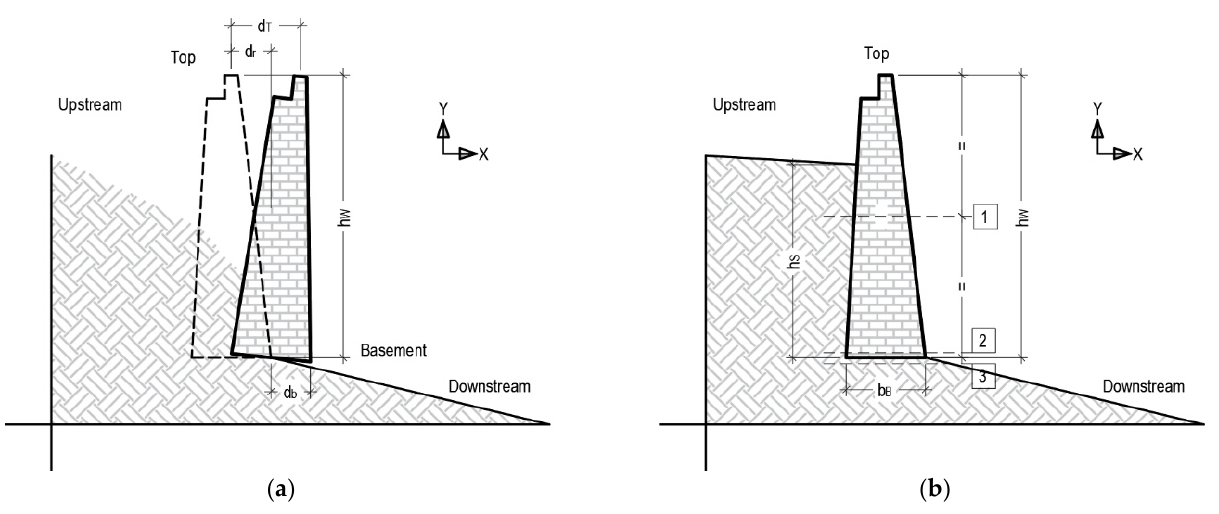
Figure 3. Typical drawing of a HUW. Relative displacements ( a ) and verification sections ( b ).